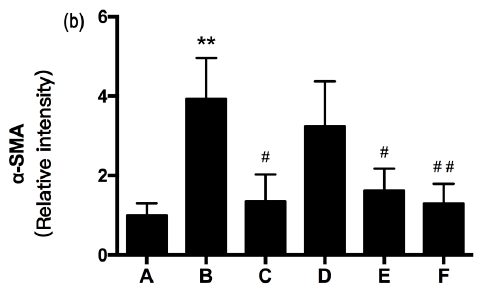
Figure 5. Effects of RRL on the levels of α -smooth muscle actin ( α -SMA) in the lung tissues after bleomycin (BLM)-induced in rats. ( a ) representative immunohistochemistry image (Bar = 50 μ m). ( A ) normal group; ( B ) model group; ( C ) PAG group; ( D – F ) are RRL groups treated with 125, 250 and 500 mg/kg, respectively; ( G ) negative control of omitted first antibody; ( H ) negative control of